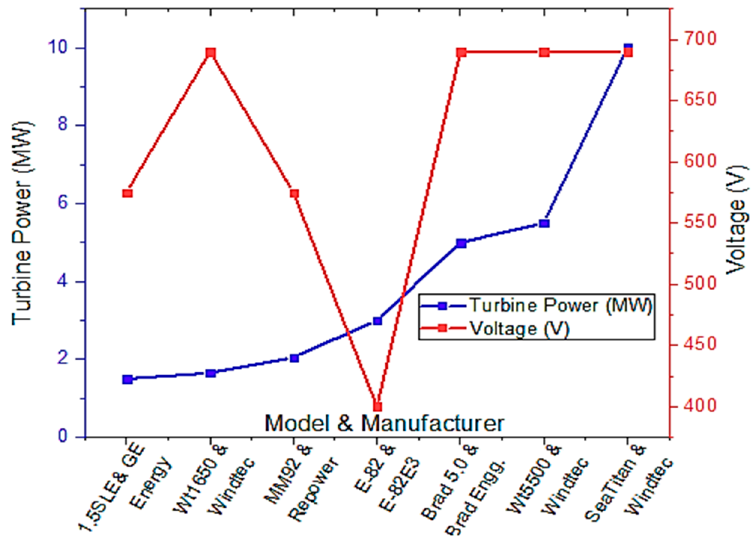
Figure 17. Summary of the voltage ratings of a few common wind turbine generators [15].